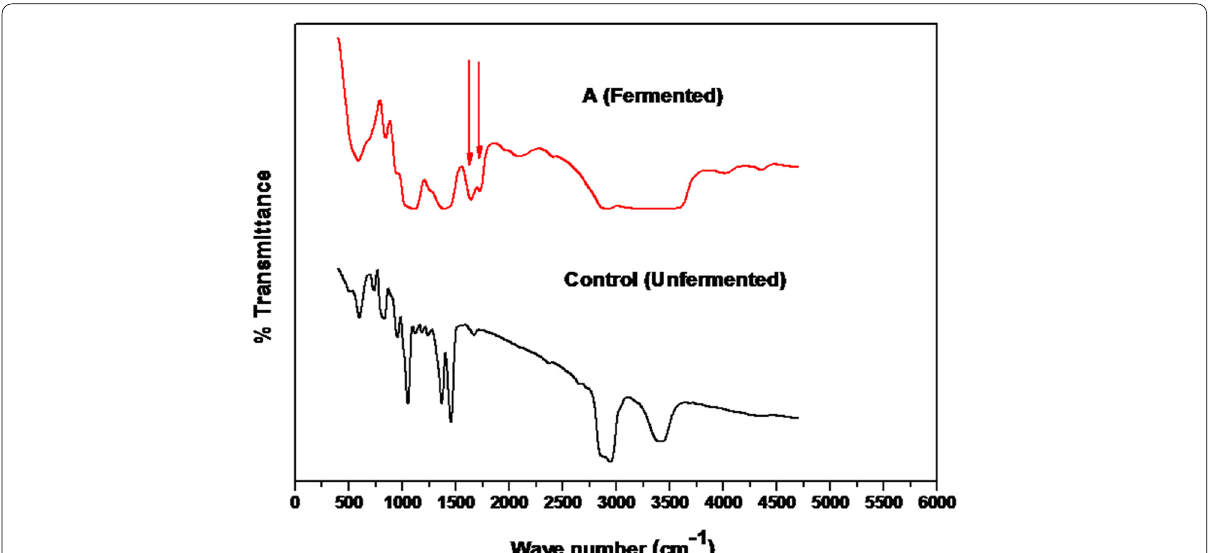
Fig. 6 FTIR analyses of cholesterol degradation by Streptomyces sp. AN. FTIR pattern for cholesterol substrate powder, control (unfermented), and A (fermented) after the fermentation process. The arrow point to the presence of the Keto group C